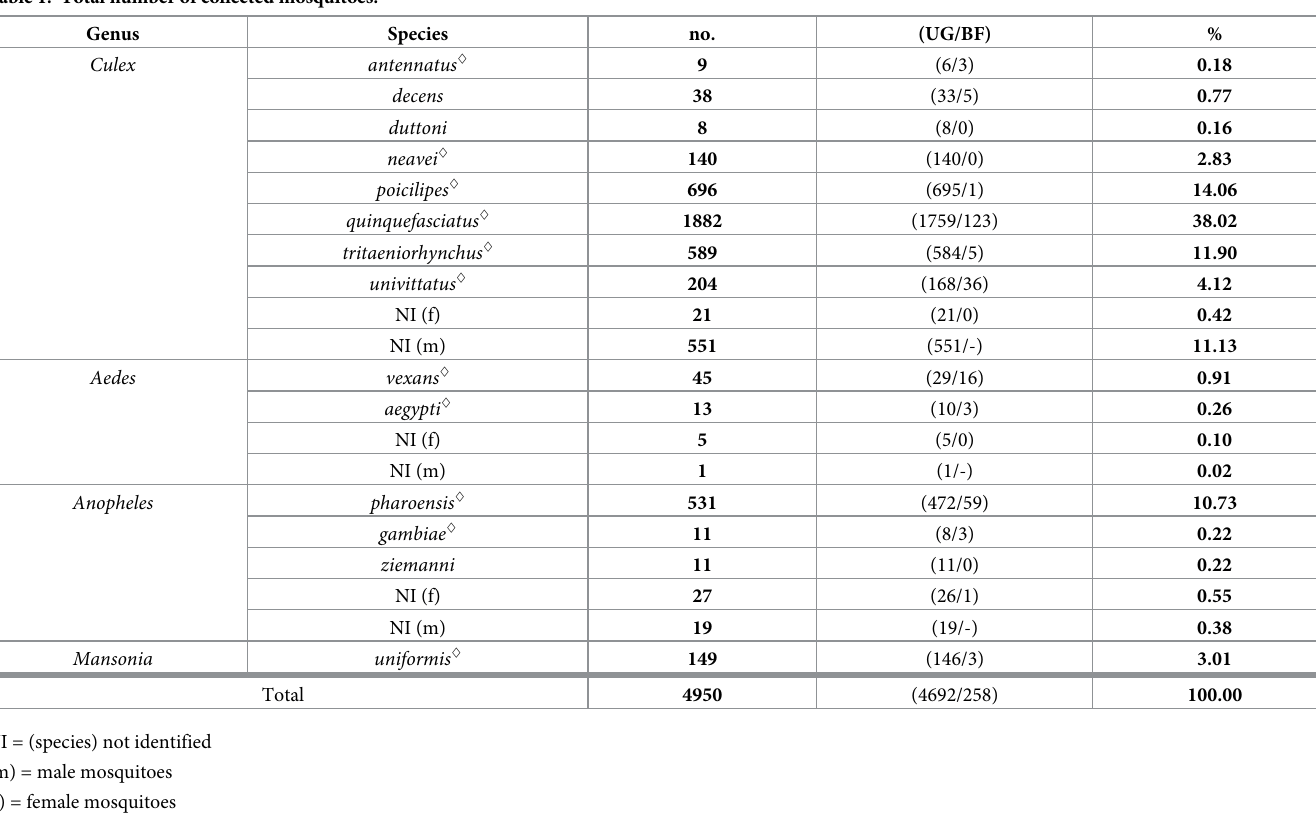
UG = unengorged mosquitoes (without visible blood meal) BF = blood-fed mosquitoes ^ = natural infection with RVFV has been described